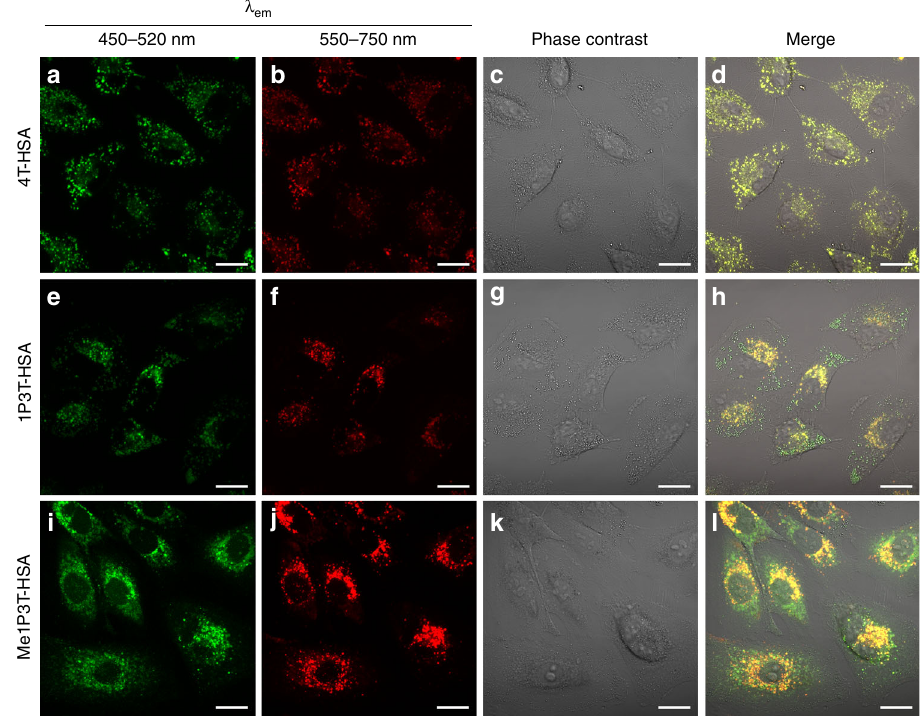
Fig. 6 Internalization, distribution and assembly of the oligothiophenes in living cells. Confocal laser scanning micrographs of A549 cells treated with oligothiophene-albumin complex 4T-HSA a – d , 1P3T-HSA e – h , and Me1P3T-HSA i – l at 15 µ M for 24 h (37 °C, 5% CO 2 ). Molecular states (450 – 520 nm, green) and aggregates (550 – 750nm, red) are visualized simultaneously (co-localization in yellow). Scale bar = 20 µ m. All three compounds were internalized ef fi ciently and show distinct localized fl uorescence signals, which vary with the different head groups